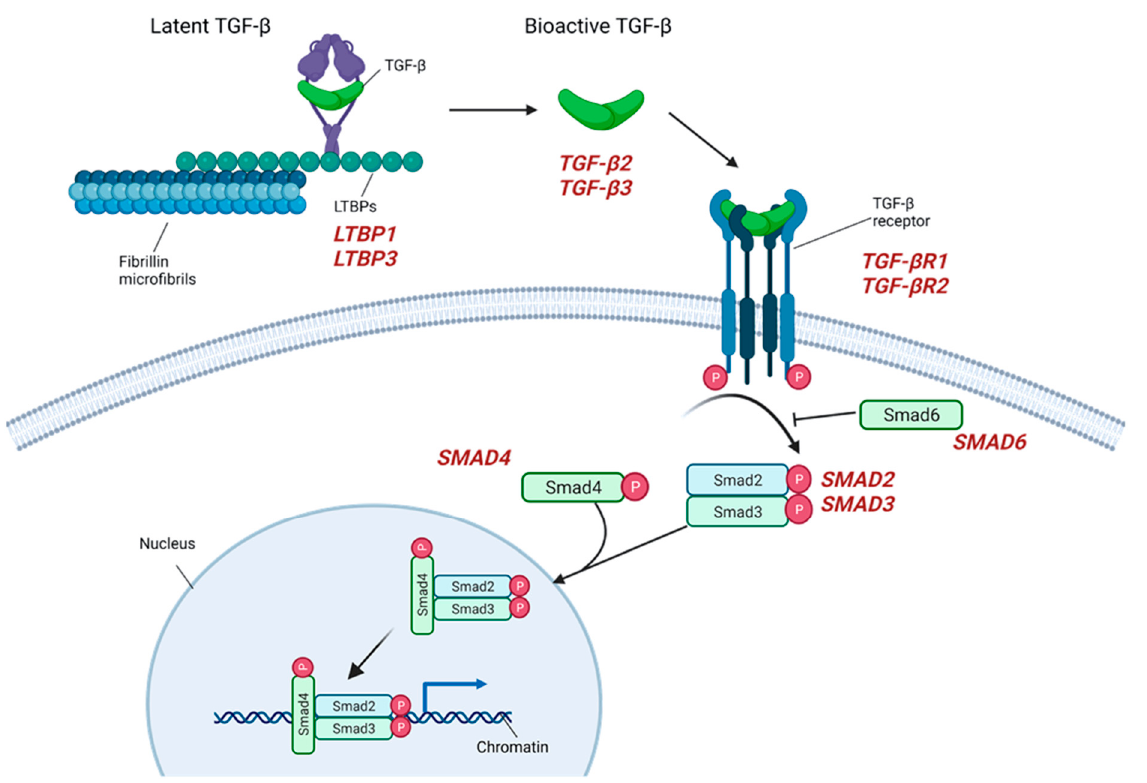
Figure 3. Schematization of the main components of TGF- β signaling. Genes codifying each component are reported in red (created in BioRender.com (accessed on 13 May 2022)).